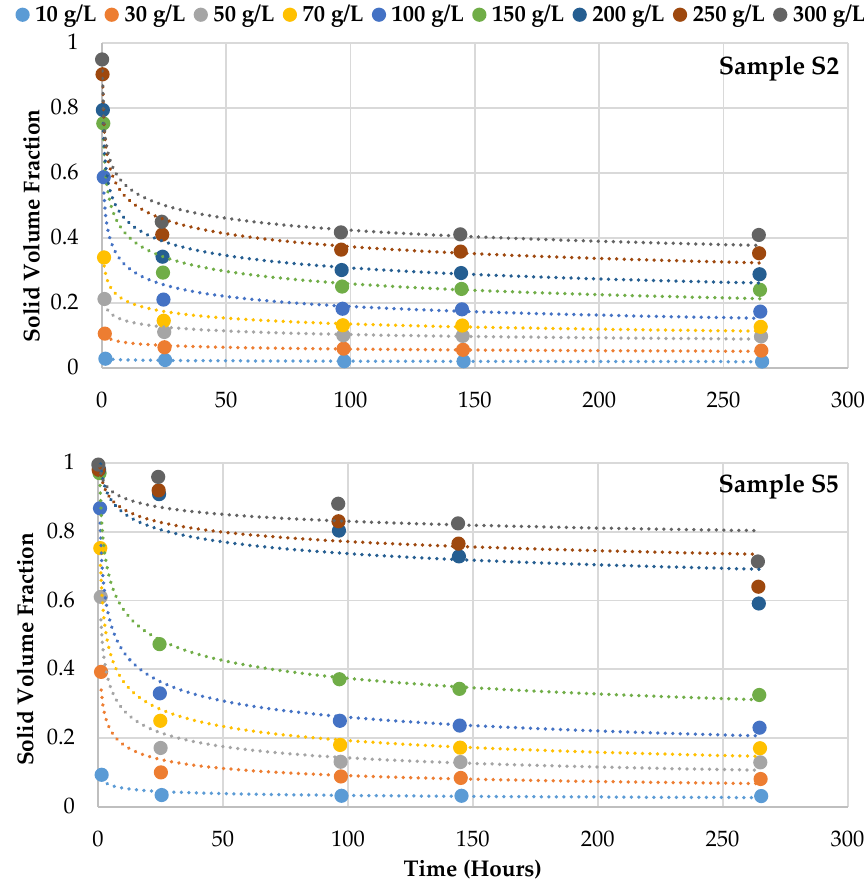
Figure 7. Temporal variations of the solid volume fractions for sediment Samples S2 and S5.